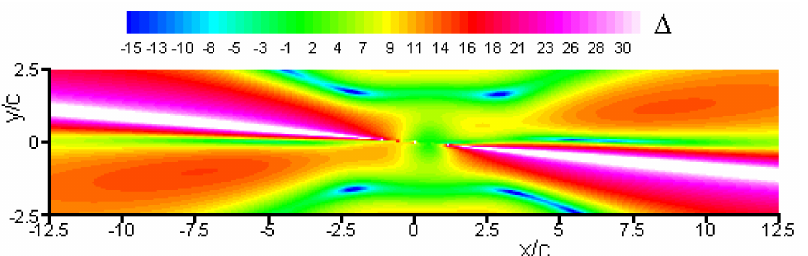
Figure 8. Low frequency ( St = 0.294) noise radiation from the trailing edge of an airfoil set at low incidence ( α = 5 ◦ ). Top: Instantaneous pressure field recorded within the vein after 10 source periods, depicted as incident ( a ) and total ( b ) components. Bottom: corresponding RMS pressure field, with incident ( c ) and total ( d ) components. For visualization purposes, all pressure fields are normalized by A max and depicted using 60-iso contours distributed over an amplitude range of [ − 1; 1] ( a , b ) and [0; 2] ( c , d ).